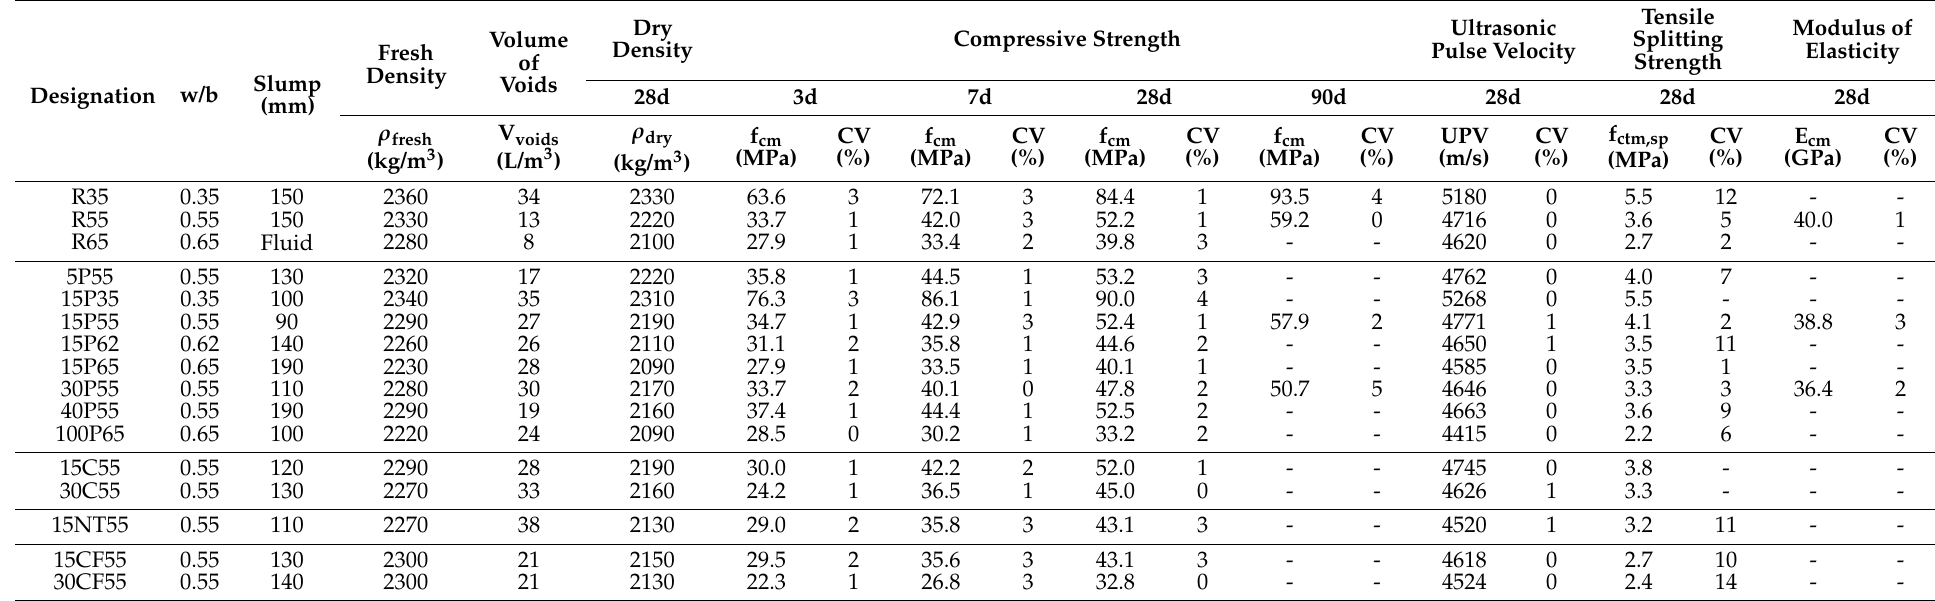
Table 4. Test results of the produced